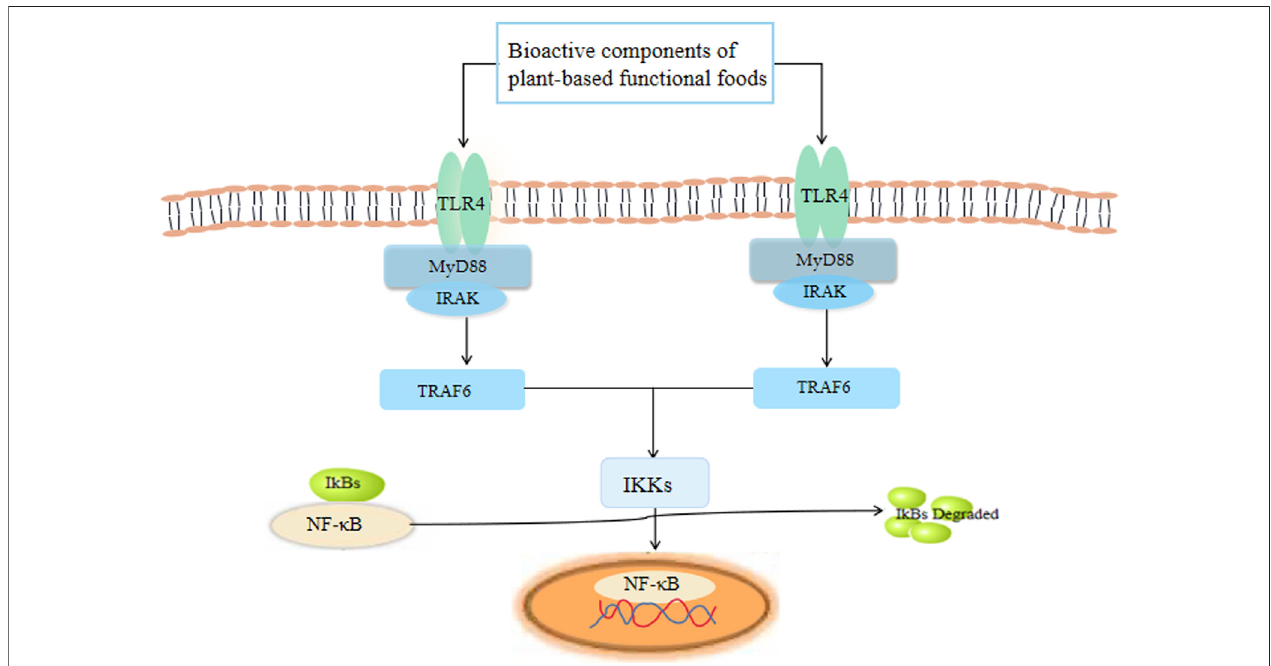
FIGURE 5 | The receptors and signaling pathways triggered by plant-based functional